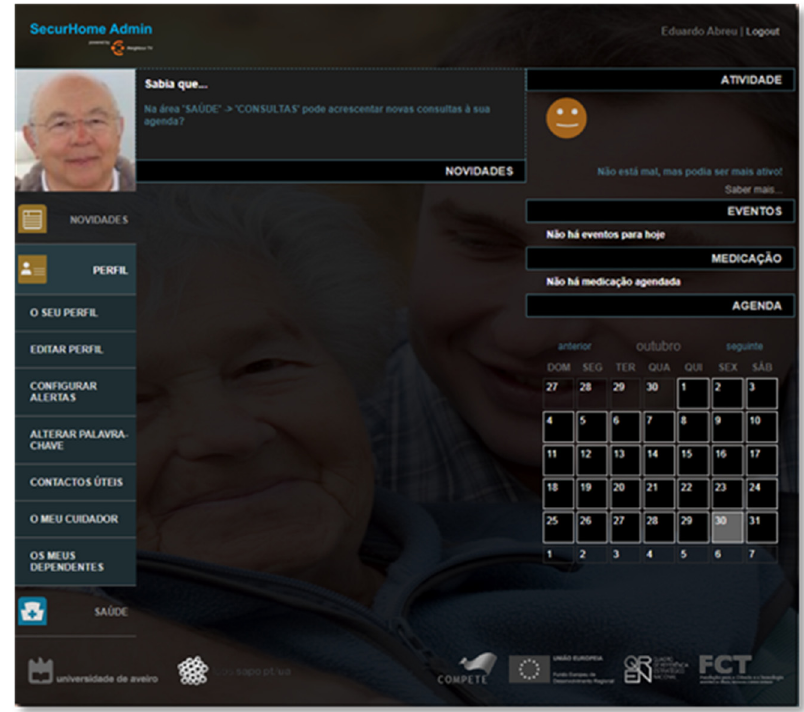
Figure 16. Profile area of the SecurHome Admin application.